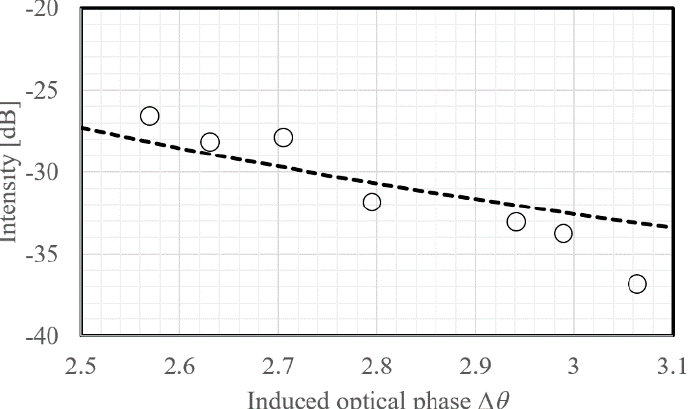
Figure 8. Intensity of ± 1st-order optical sidebands normalized by ± 3rd-order optical sideband intensity, obtained from the experiment (open circles) and analytical model where ER of the polarizer is 41.5 dB (dashed line). At each ∆ θ , η is set to satisfy Equation